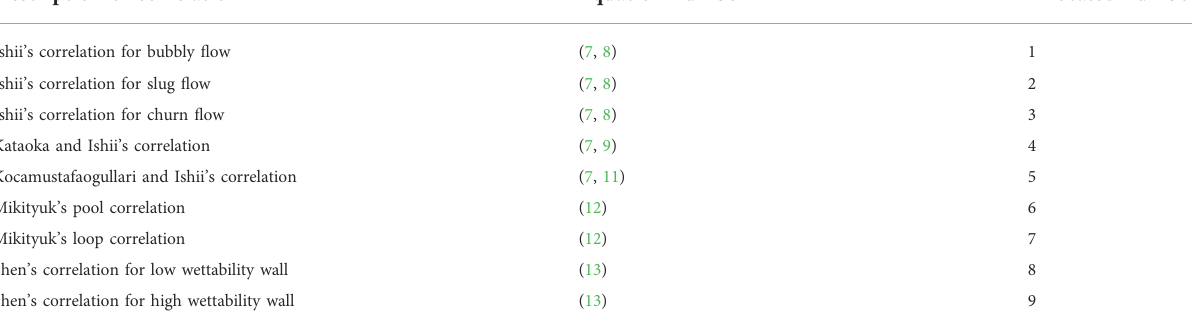
TABLE 1 Summary of the nine